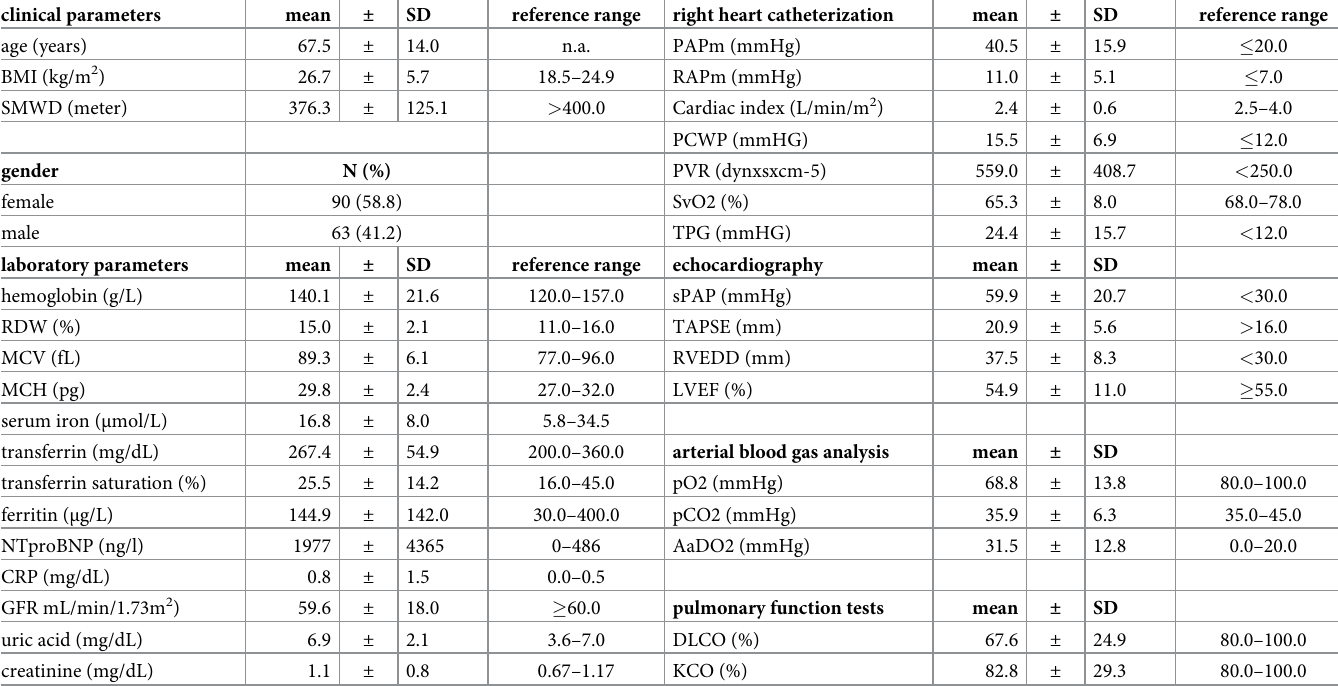
Table 1. Patients’ characteristics at first consultation (N =